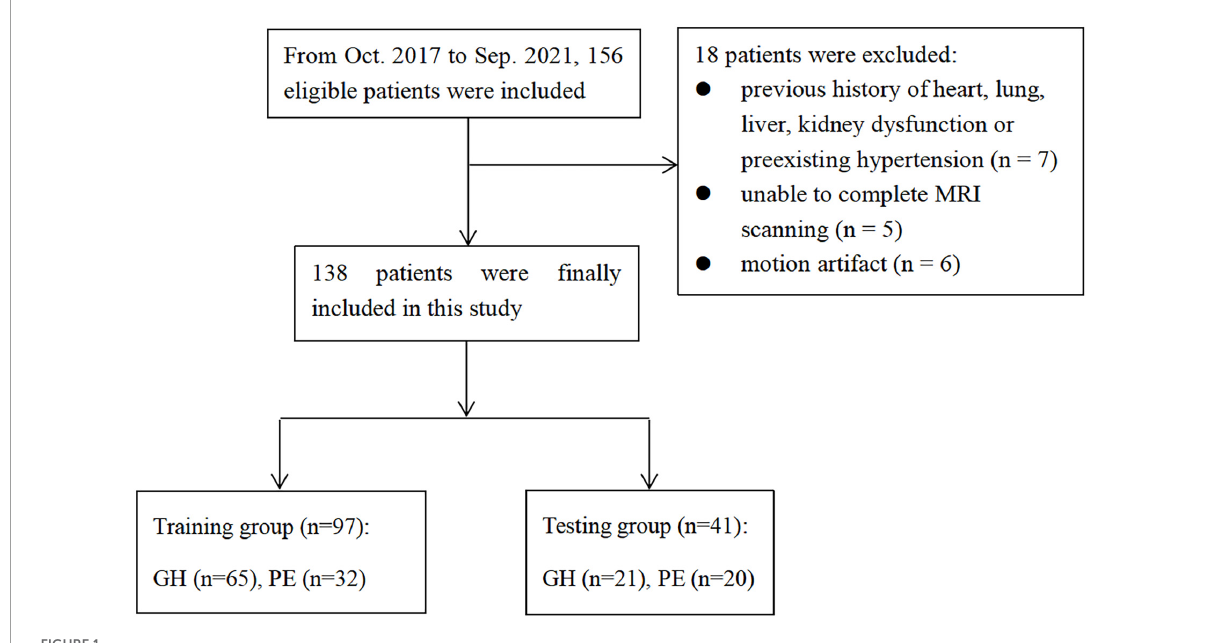
FIGURE1 The workflow of this